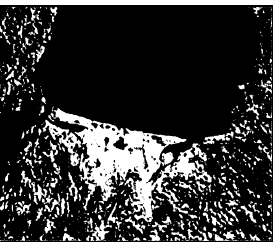
Figure 10. The binary image result of water and other areas